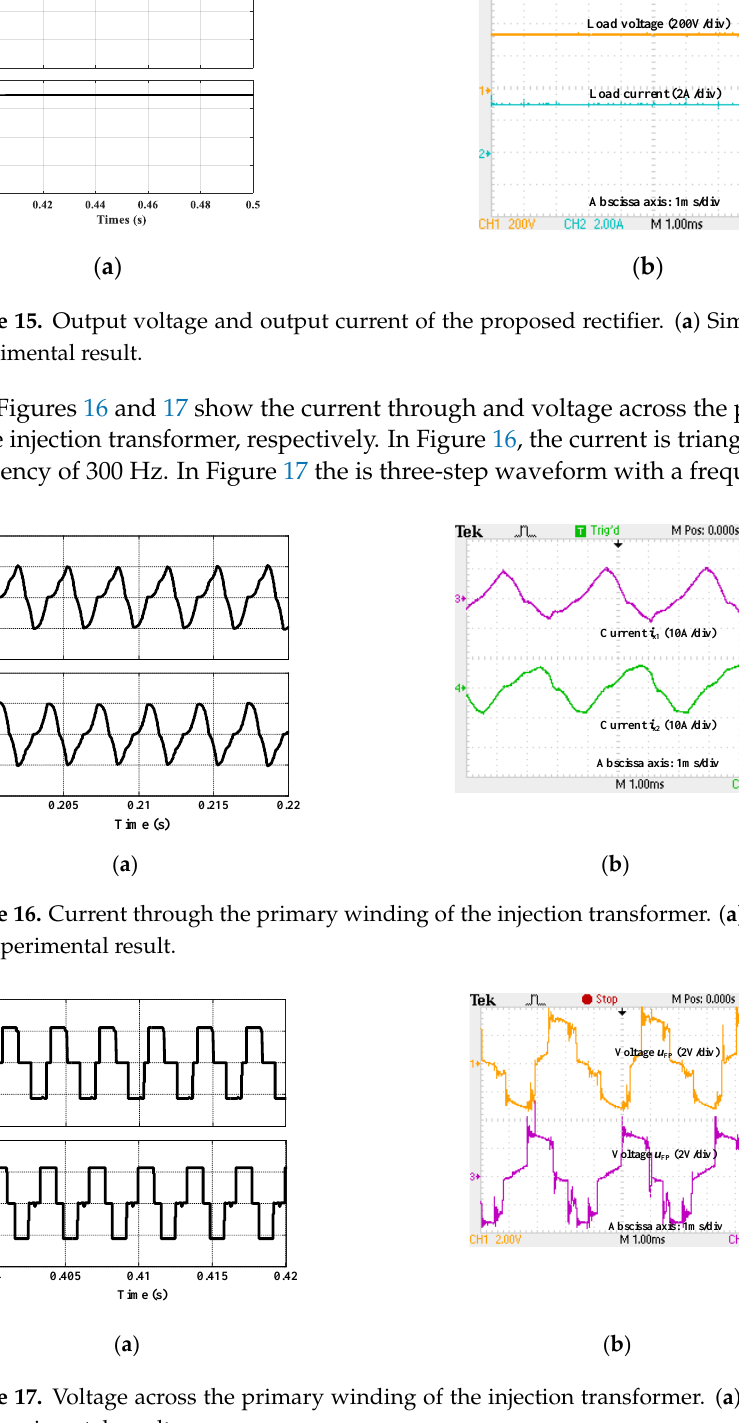
Figure 17. Voltage across the primary winding of the injection transformer. ( a ) Simulation result. ( b ) Experimental result.